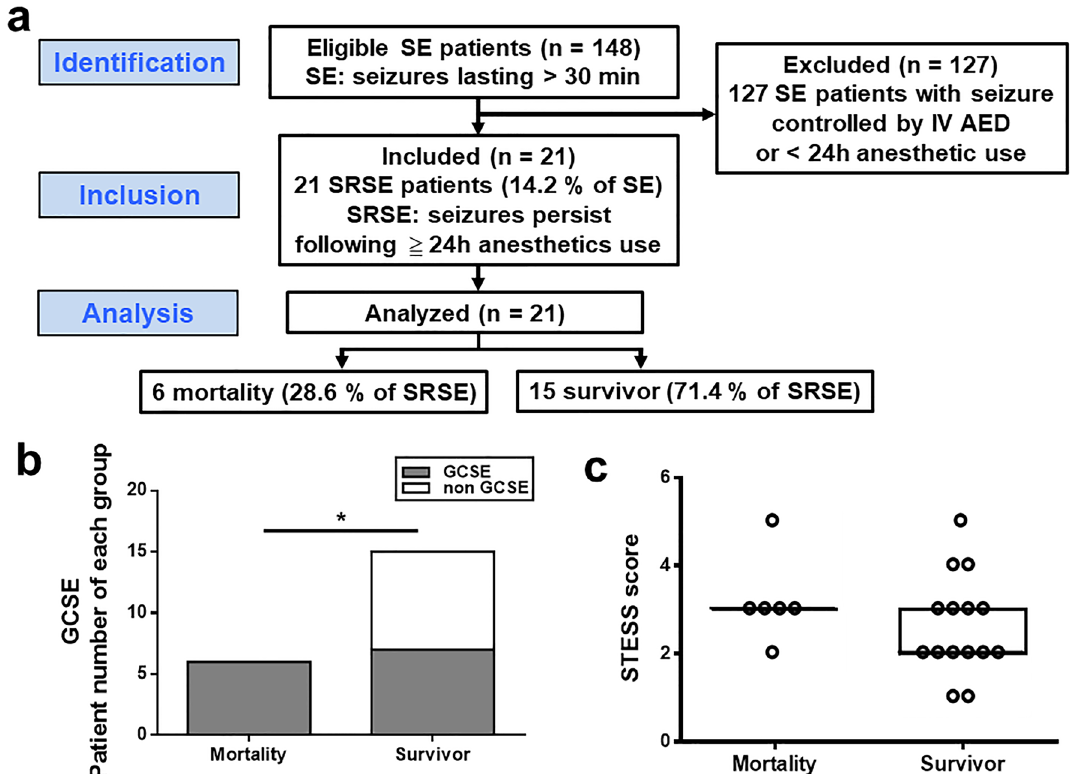
Figure 1. Patient distribution, initial SE type, and SE severity in patients with SRSE. ( a ) Study flowchart in line with STROBE statement and the patient distributions in the mortality and survival groups. ( b ) Numbers of patients with generalized convulsive SE in the mortality and survival groups at hospital admission. ( c ) Initial SE severity was assessed using the STESS in the mortality and survival groups. * p < 0.05. Dark lines indicate median values, and boxes indicate interquartile ranges in ( c ). SE status epilepticus, SRSE super-refractory status epilepticus, GCSE generalized convulsive status epilepticus, STESS status epilepticus severity score. STROBE strengthening the reporting of observational studies in